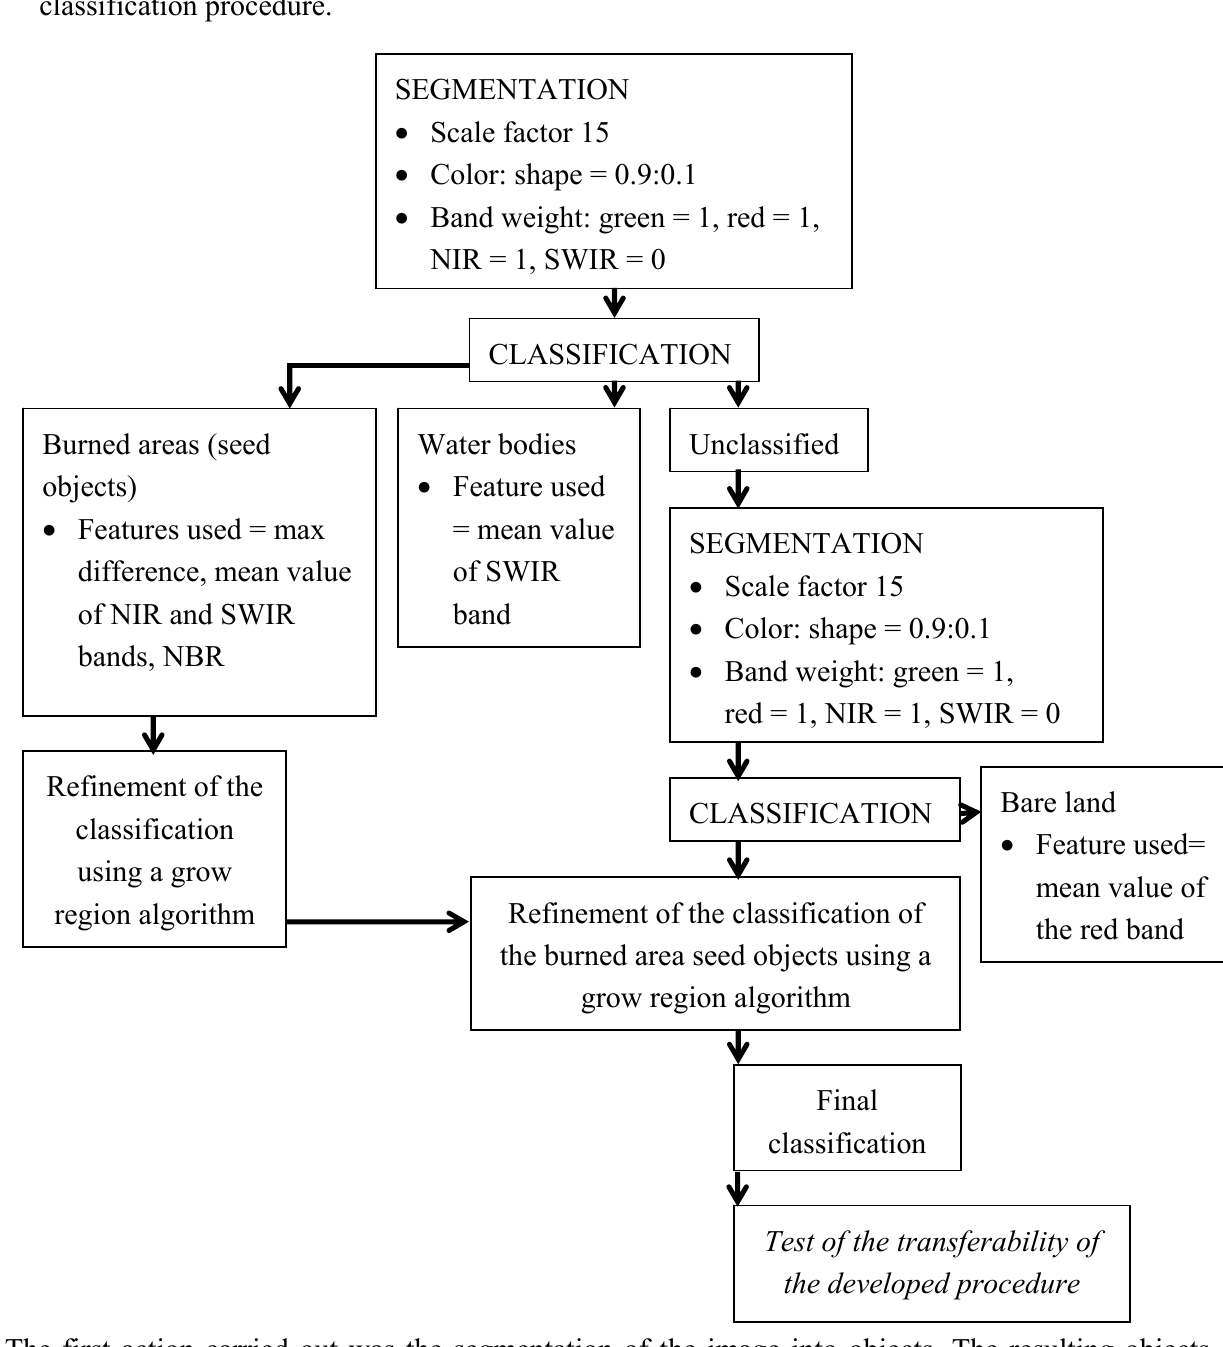
Figure 2. Flowchart of the methodology followed during the development of the classification